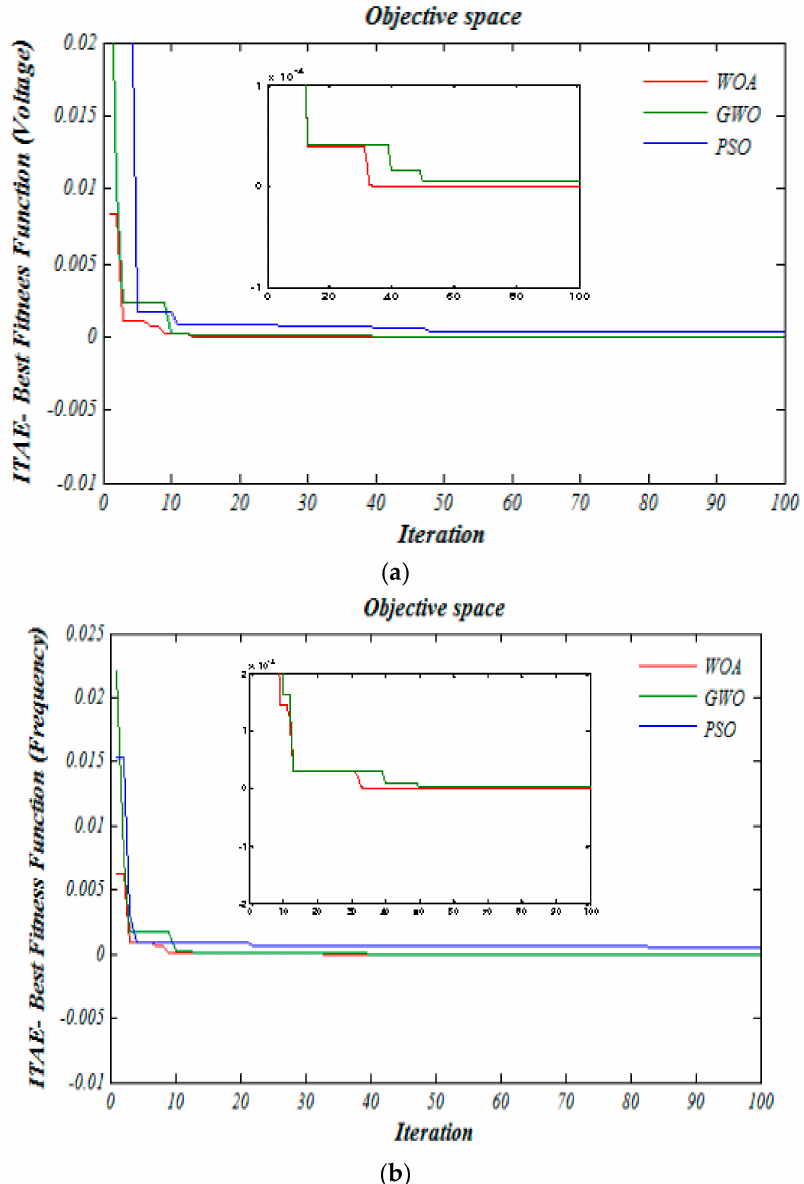
Figure 6. Obtained fitness function curves during change of MG operating mode. ( a ) Best Fitness Function for Voltage; ( b ) Best Fitness Function for